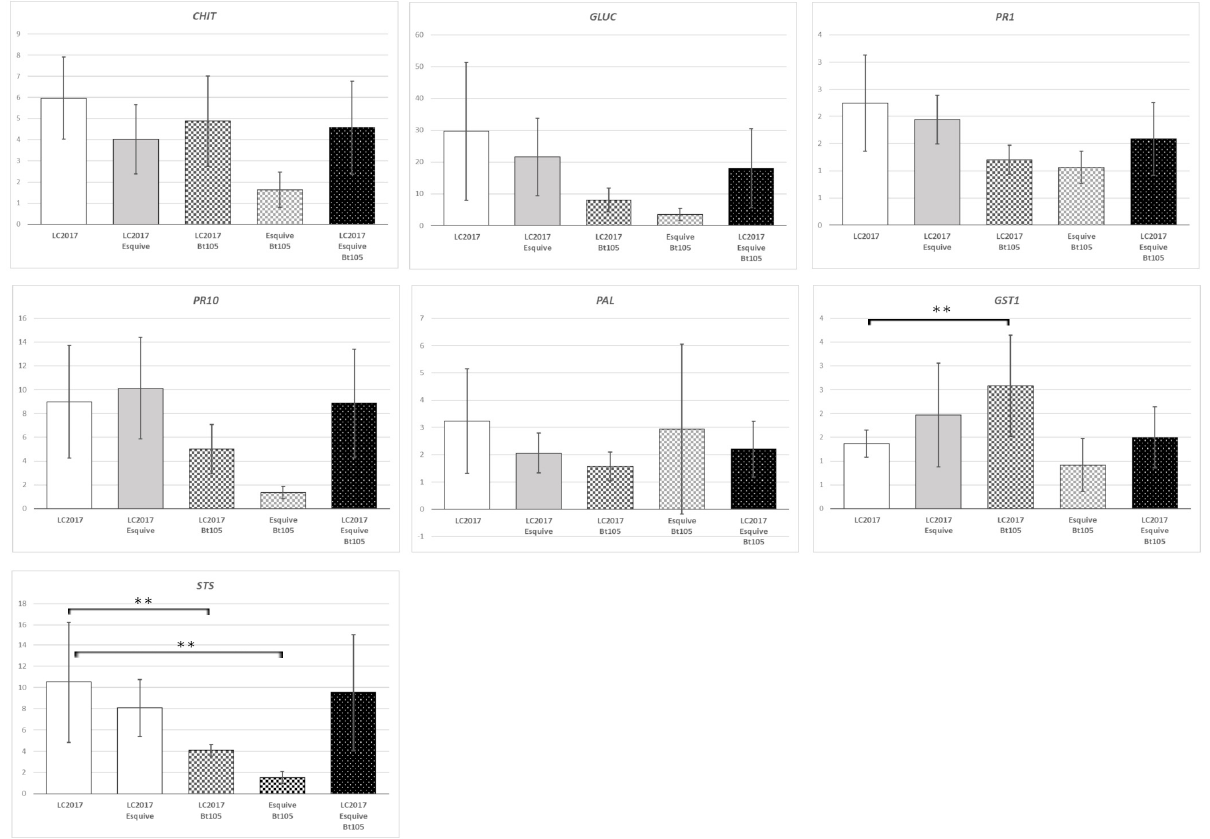
Figure 6. Overexpressed genes (values > 2) at T0 + 2d in Cabernet Sauvignon cuttings with single (LC2017) or double (LC2017 + Esquive ® ) treatment, not inoculated or inoculated with L. theobromae strain Bt105. Statistical analysis with the Mann-Whitney U test showed no significant differences between medians of LC2017 and LC2017 + Esquive ® and between LC2017 + Bt105 and LC2017 + Esquive ® + Bt105. Only a significant effect of pathogen presence was observed in some genes in LC2017-treated vines. The asterisk indicates a statistical significance (Mann-Whitney U test) between the medians of the two considered conditions. ** = p <